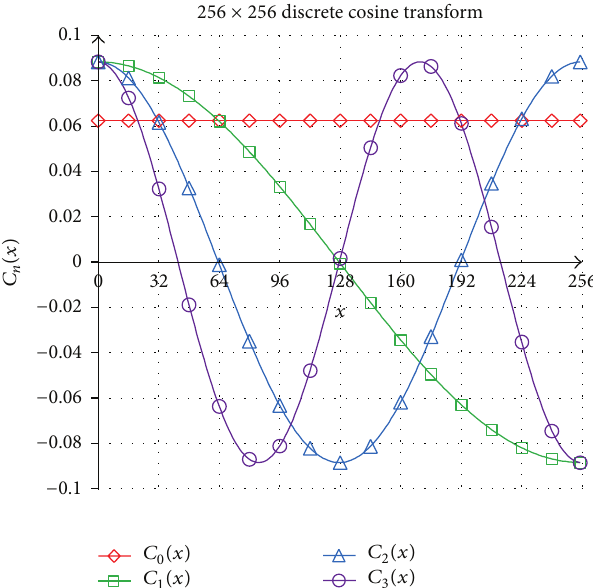
Figure 3: The first four 256×256 DCT of set 𝐶 𝑛 (𝑥) for 𝑛 = 0,1, 2, 3